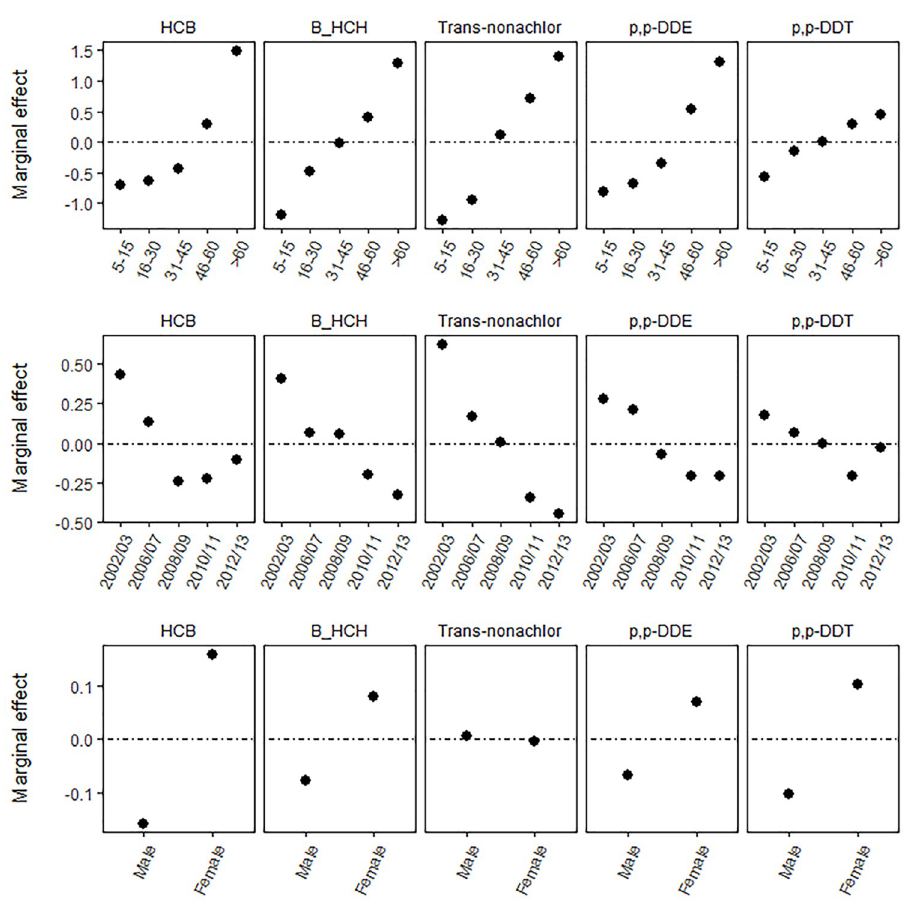
Fig 4. Partial dependence plots of BRT models. Partial dependence plots of the marginal effects of age group (top), time (middle) and gender (bottom) on the concentrations of HCB, β -HCH, Trans-nonachlor, p,p’ -DDE and p,p’ -DDT where the zero-point of the marginal effect indicates the model expected OCP concentration. Values above zero indicate higher concentrations than expected and values below zero indicate lower concentrations.